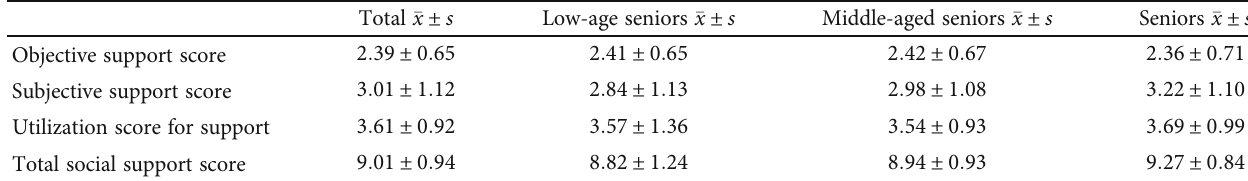
Table 1: Social support scores of older people in di ff erent age groups in Nanjing.